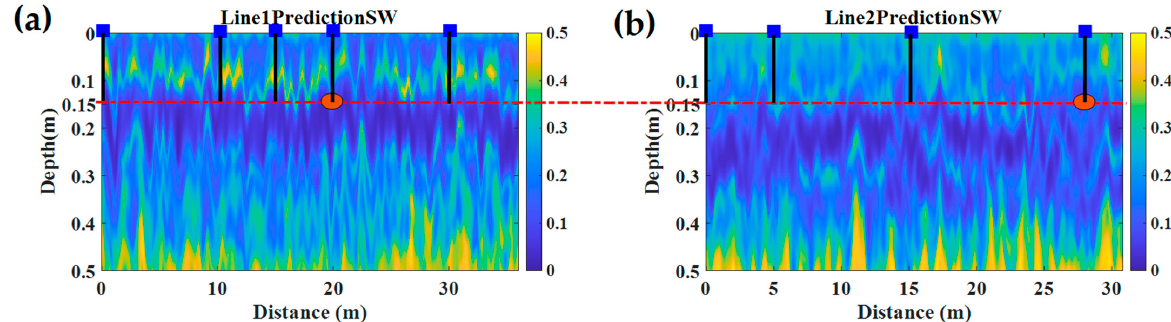
Figure 10. Distribution of soil volumetric water content in the spatial domain. ( a ) Distribution of VSWC spatial domain under line 1 and ( b ) distribution of VSWC spatial domain under line 2. The brown ovals indicate soil sampling locations, while the black probes with blue tops indicate locations where TDR probes were used for sampling.